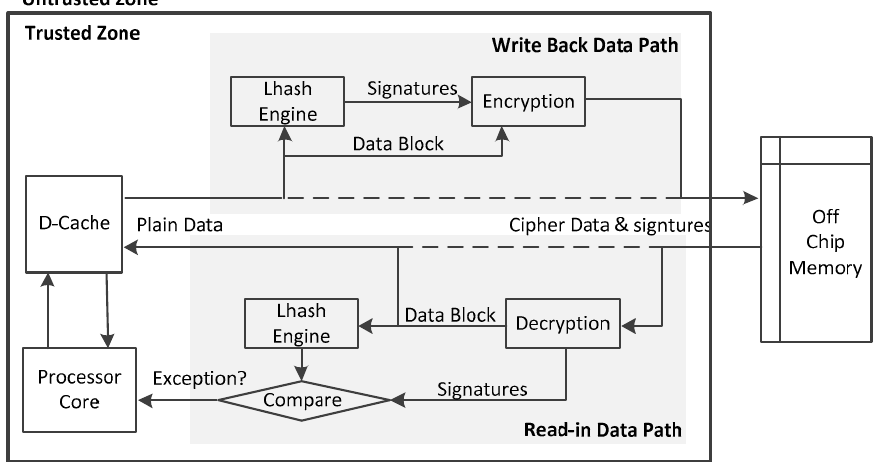
Figure 3. Memory access data path for the proposed scheme.